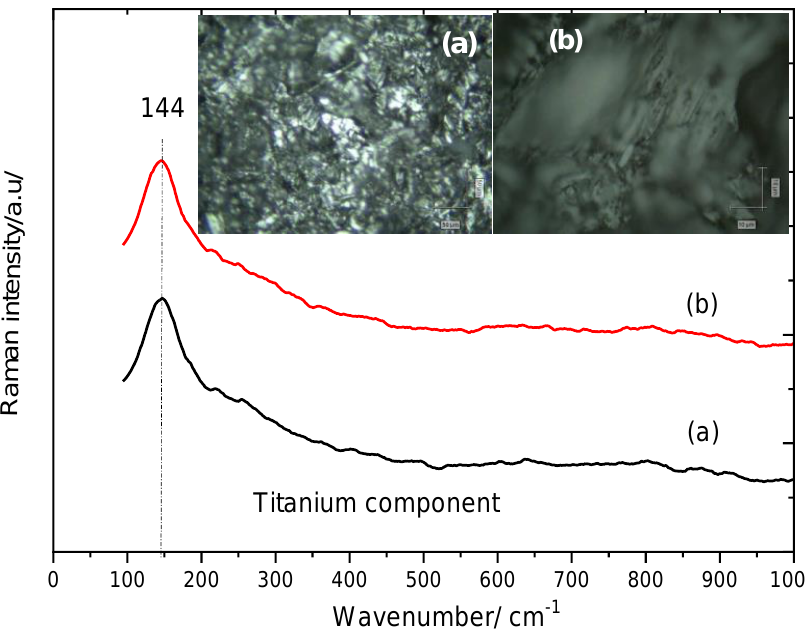
Figure 3. Micro-Raman spectra recorded on the surface of tibial metallic component (titanium). ( a ) As supplied from the producer; ( b ) retrieved prosthetic component along with the corresponding microscopic image (inset). Scale bar 50 µm. Y spectral offset was applied for clarity.